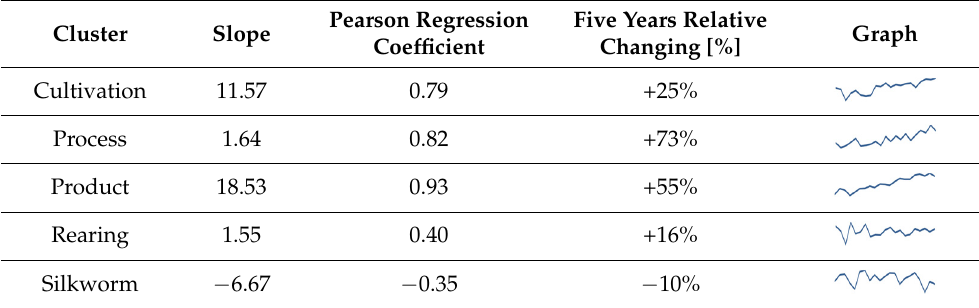
Table 8. Analysis of clusters normalized per cluster by considering their slope, Pearson regression coefficient, and their relative increment in the past five years.